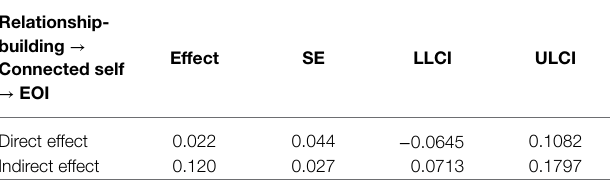
TABLE 4 | Bootstrapping analysis of the mediation effect of the connected